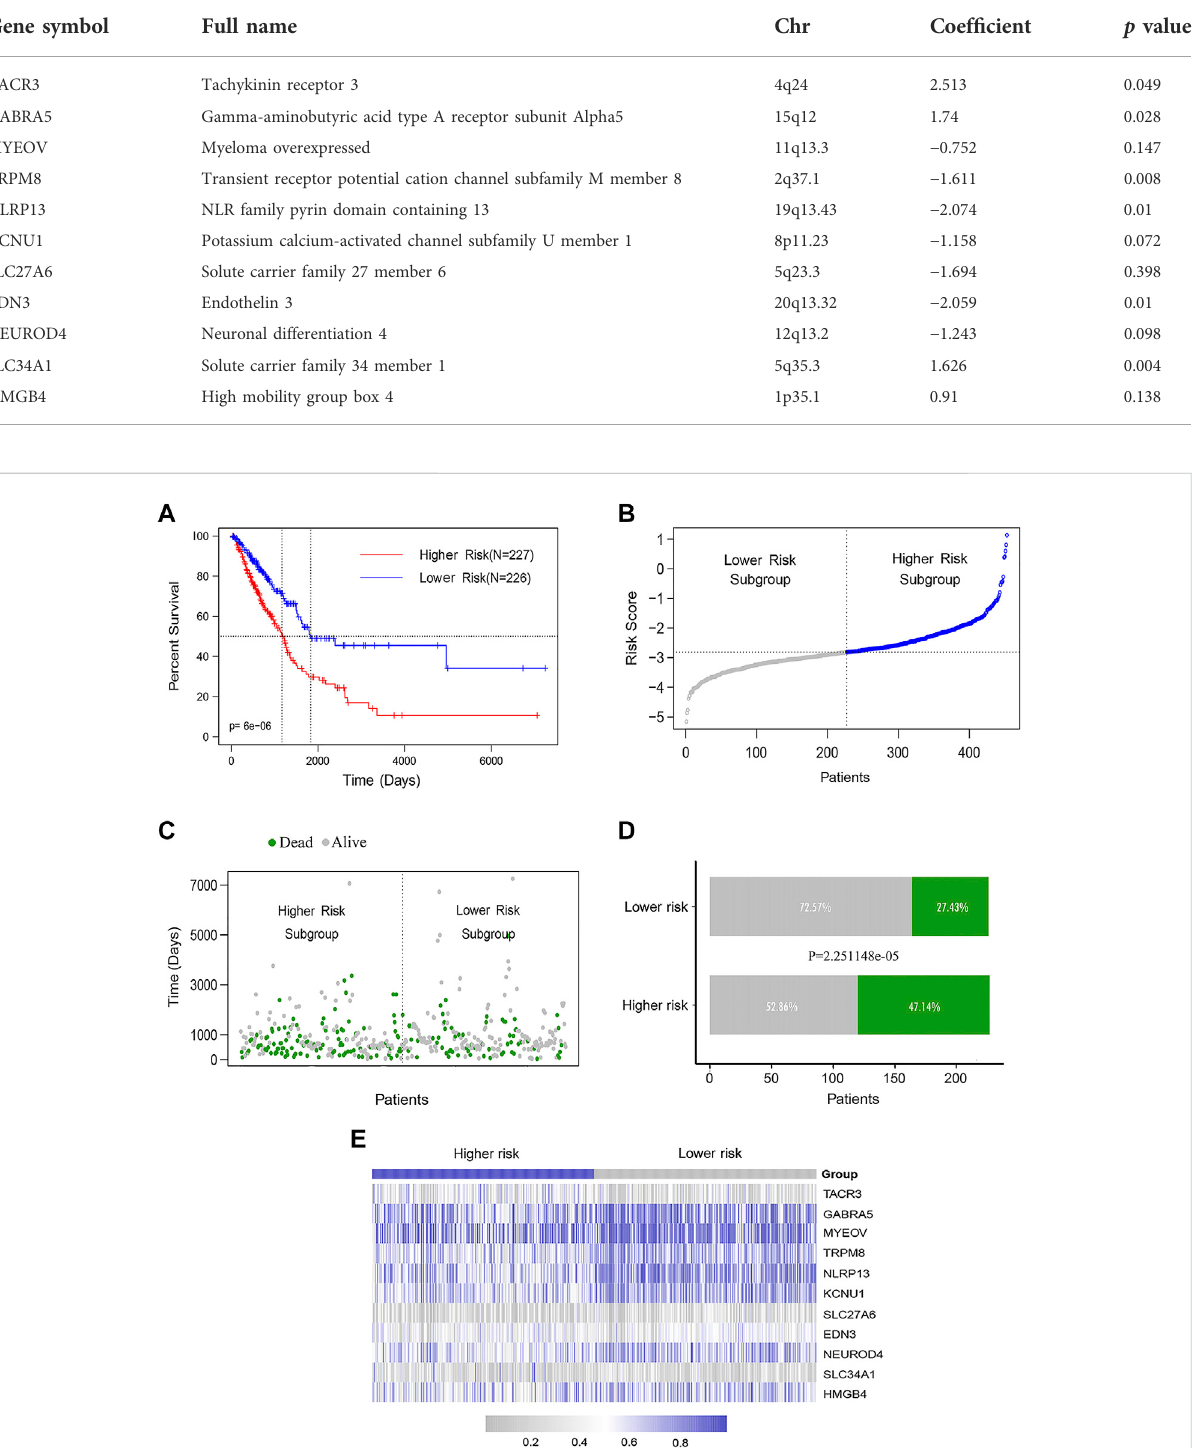
TABLE 2 Eleven mrDEGs identi fi ed as a DNA methylation signature prognostic model.